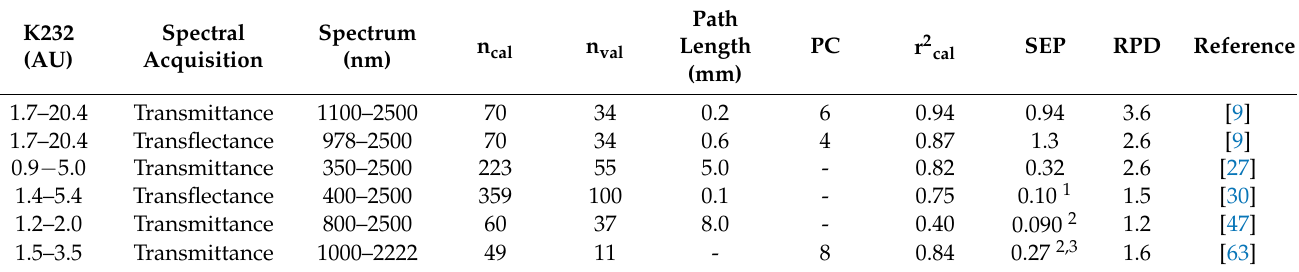
Table 5. PLS statistics obtained for K232 of olive oils using different K232 ranges, visible/NIR spectral intervals, and optical path lengths.